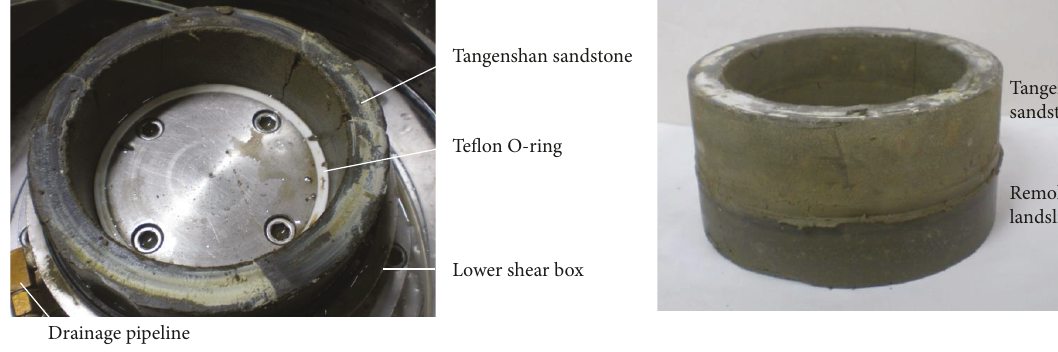
Figure 8: Sample arrangement for the ring shear test.